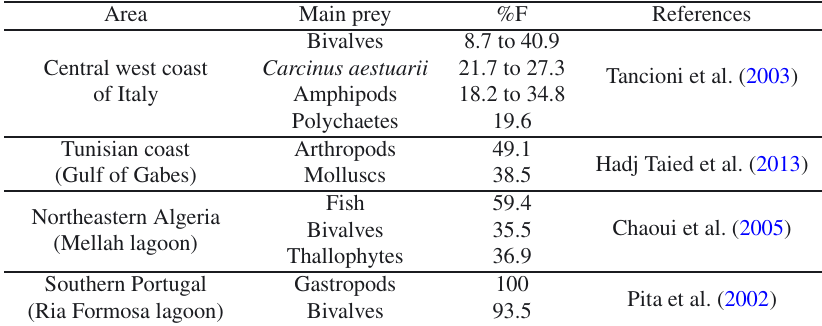
Table 1. Percentage of frequency of occurrence (%F) for main prey of Sparus aurata in the southern part of the distribution